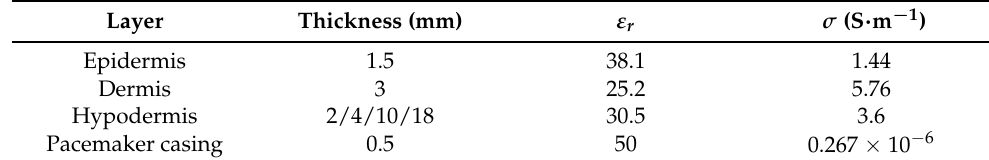
Table 2. Thickness and dielectric properties of the multilayer model (frequency of 2.4GHz) [40].